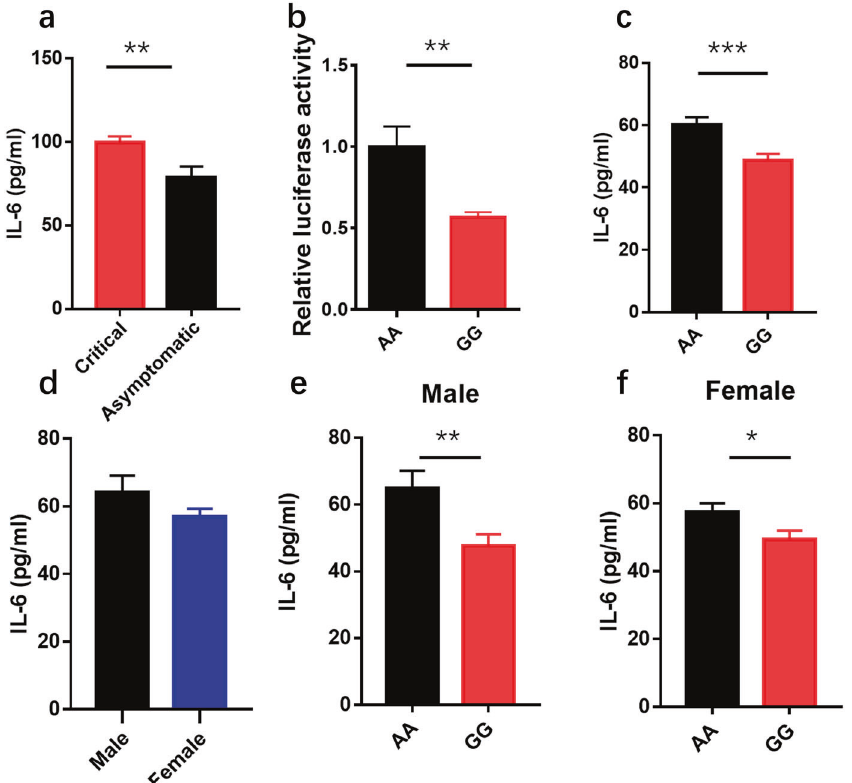
Fig. 3 IL-6 rs2069837 region decreased its expression in the COVID-19 patients and its sex-speci fi c. a Serum IL-6 concentrations between severe patients ( n = 9) and asymptomatic patients ( n = 34). b The luciferase activity of IL-6 rs2069837 region and its variation. Representative of four independent experiments with three biological replicates. c Serum IL-6 concentrations are shown according to IL-6 rs2069837 groups, AA type ( n = 480), GG type ( n = 28). d Baseline of IL-6 in the male ( n = 224) and female ( n = 284). e IL-6 level are shown according to IL-6 rs2069837 groups in the male, AA type ( n = 214), GG type ( n = 10). f IL-6 level are shown according to IL-6 rs2069837 groups in the female. AA type ( n = 266), GG type ( n = 18). Data are mean ± SEM. Signi fi cance determined by unpair T test, * P < 0.05, ** P < 0.01, *** P < 0.001